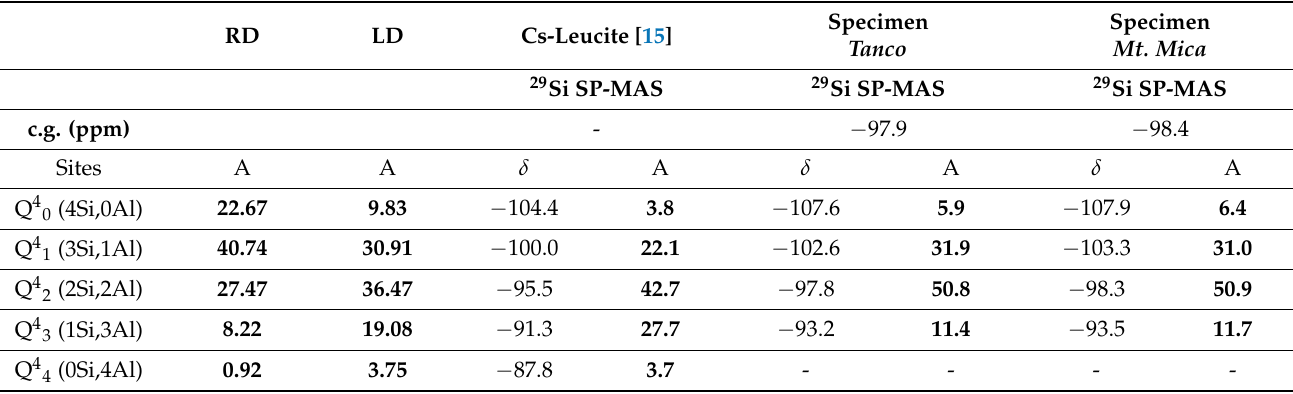
Table 3. Deconvolution of the 29 Si SP-MAS NMR spectra at 9.4 T of the two specimens of pollucite, in comparison with other experimental and theoretical possibilities.